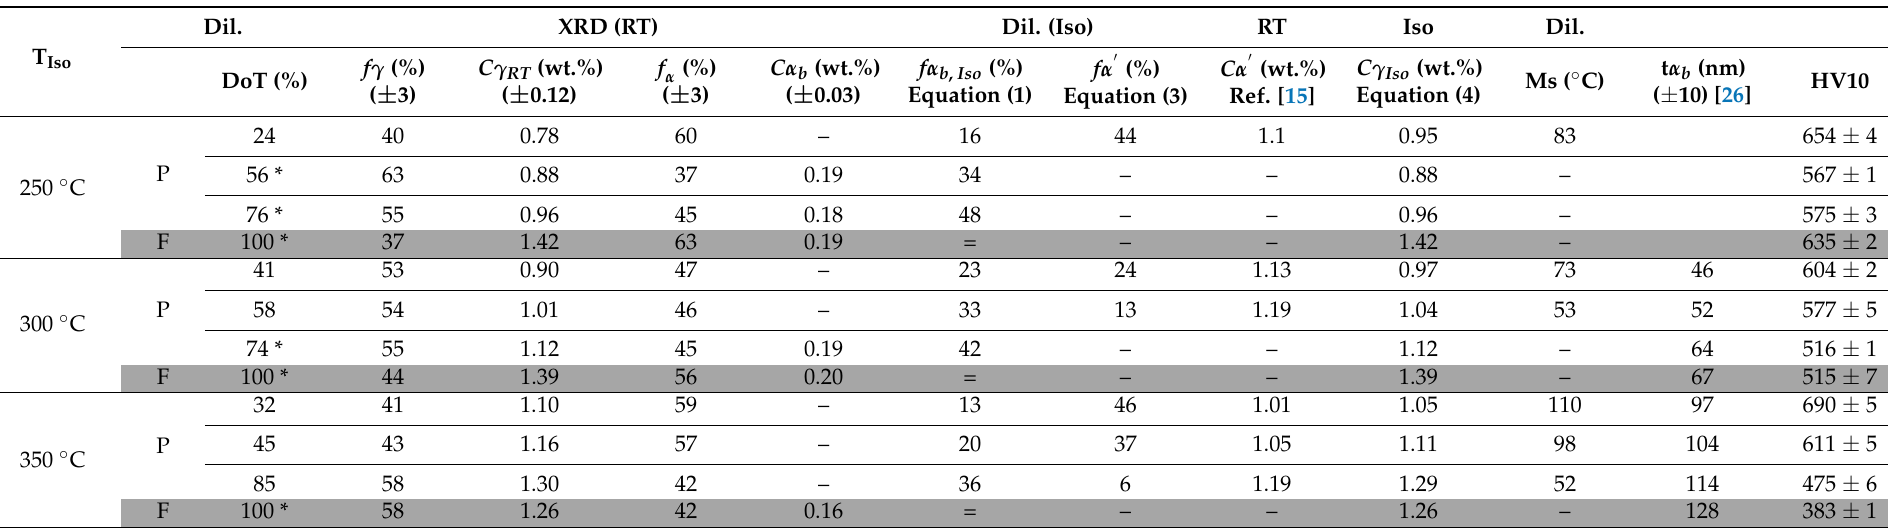
Table 2. Volume fraction ( fi ) and carbon content ( Ci ) of identified phase in the microstructures of 1C2Si at room temperature; α b is bainite, α (cid:48) is martensite, γ is austenite and α = α b + α (cid:48) . P and F stand for partial and full transformation, while RT refers to room temperature and Iso refers to isothermal temperature. The martensitic transformation start temperature Ms, plate thickness ( t α b ) and hardness HV10 are also included. An asterisk (*) indicates that no martensite was detected on cooling to room T. Dil. stands for dilatometry and DoT stands for degree of